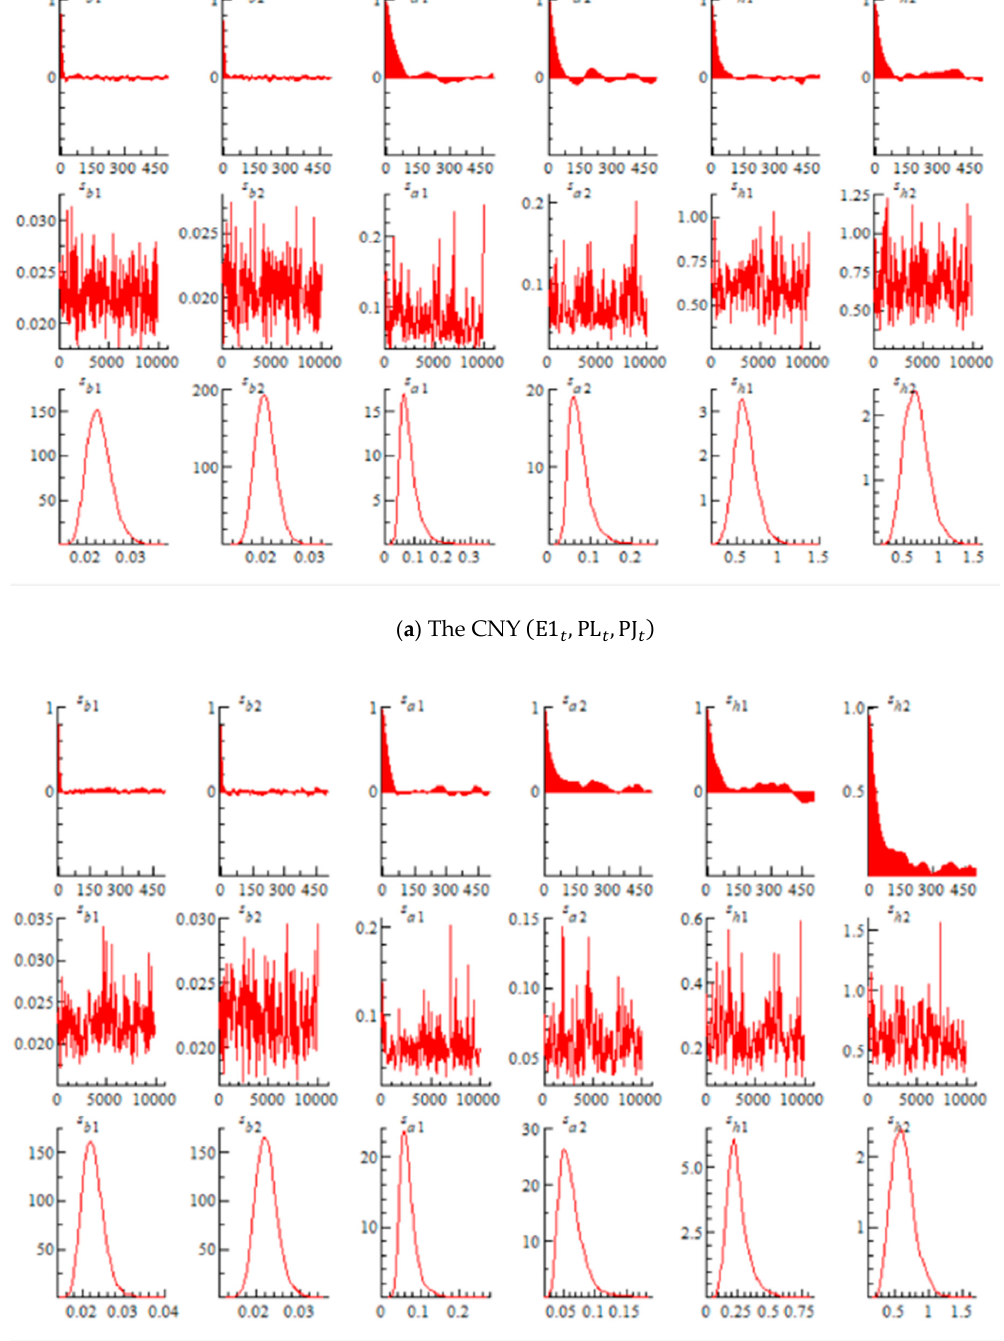
Figure 2. The sample autocorrelation function (upper), sample path (middle), and posterior probability density function (bottom) of TVP-VAR parameters. s b1 , s a1 , and s h1 are error terms of the original time-varying parameters based on the first n 0 sub-samples. s b2 , s a2 , and s h2 are error terms of the original time-varying parameters based on the last n 1 sub-samples. The vertical axis of the upper figure is the sample autocorrelation, and the horizontal axis denotes the number of iterations. The vertical axis of the middle figure is the sample path and the horizontal axis is the number of iterations. The vertical axis of the bottom figure is the posterior probability density and the horizontal axis is the deviation from the